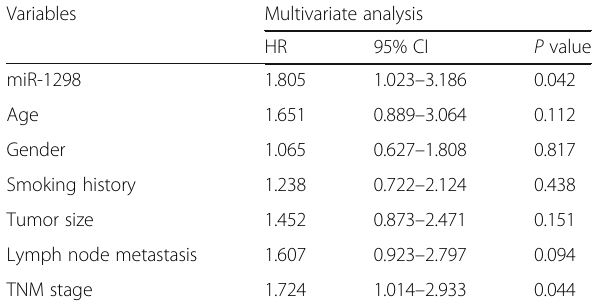
Table 2 Cox regression analysis in the patients with NSCLC